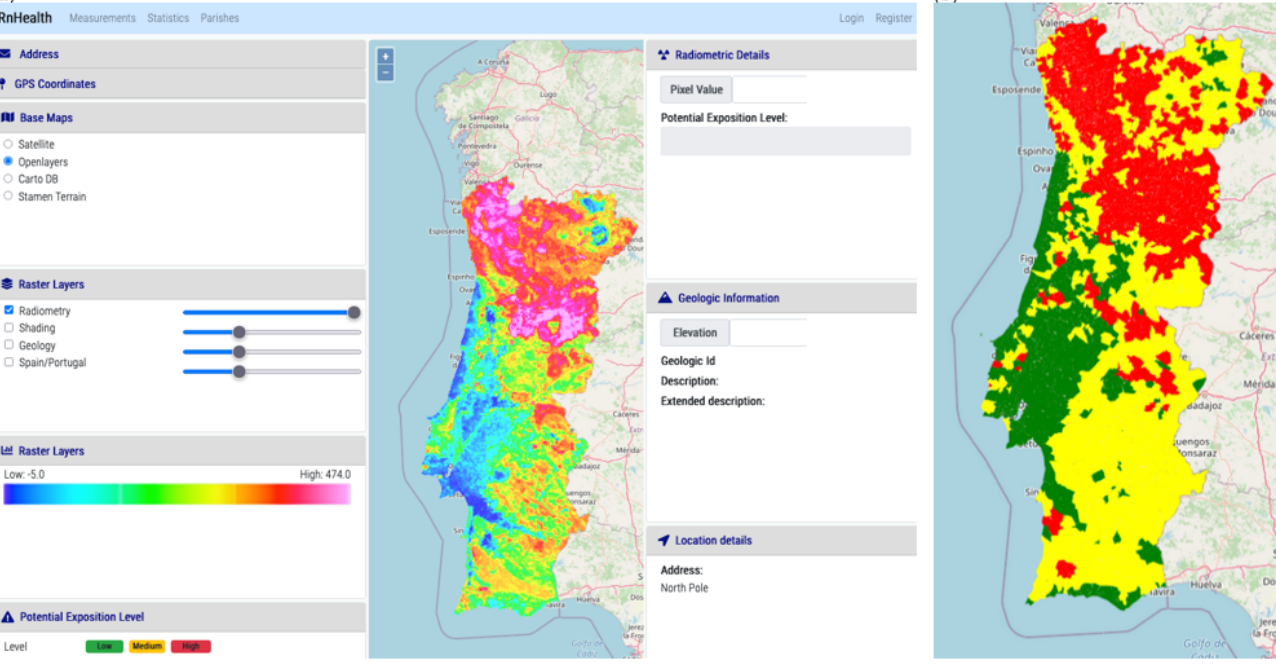
Figure 4. WebGIS RnHealth platform, which presents ( a ) the user-friendly interface for entering data on the location (available in Phase I of the project); and ( b ) the radon potential display interface, with the indication of qualitative information about the radon potential.